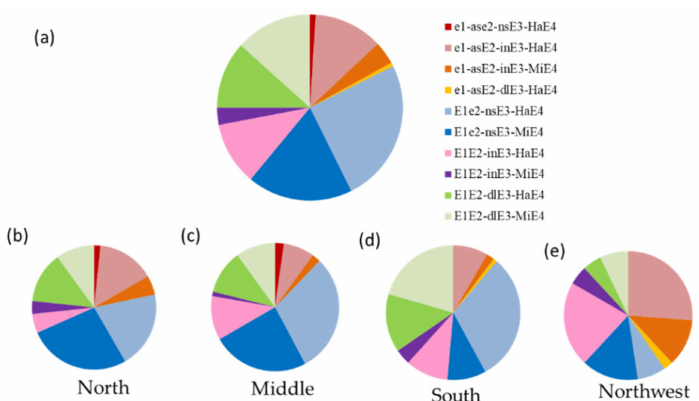
Figure 1. Frequency of E1 – E4 combinations ( a ) in four sub-regions; ( b ) north sub-region; ( c ) middle sub-region; ( d ) south sub-region; ( e ) northwest sub-region. Different colors represent different E